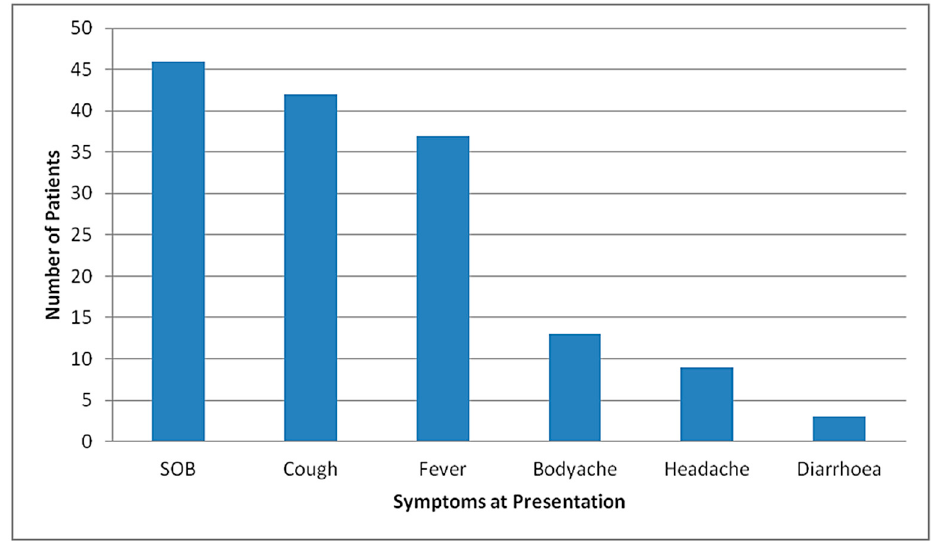
Figure 6. Distribution of symptoms at presentation among mortalities at STIDH (n = 50).